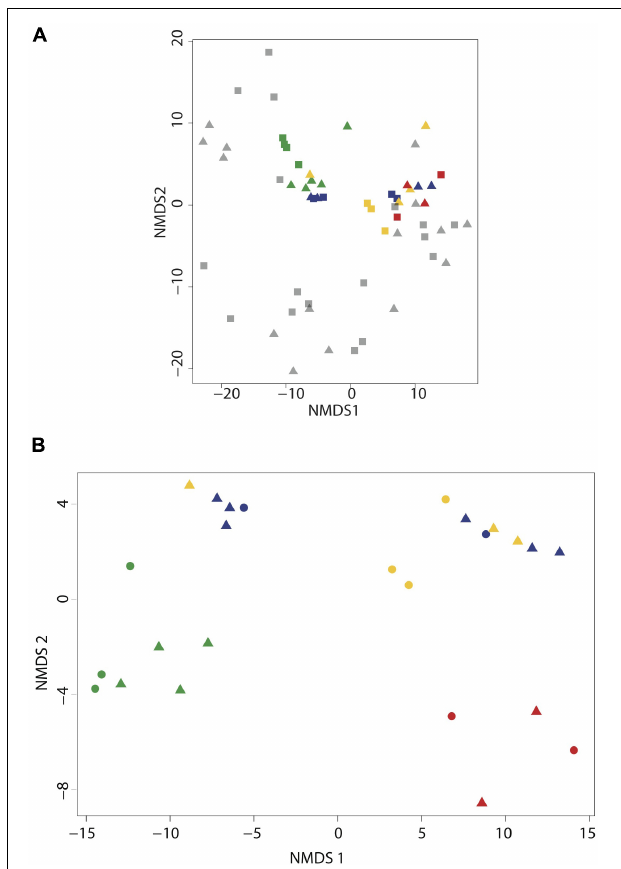
FIGURE 2 | Cluster analysis of small subunit ribosomal RNA (SSU rDNA) gene pyrotag data for the Saanich Inlet time-series (2006–2011) and SCOR workshop samples collected at 165 and 185 m. (A) NMDS based on Manhattan distance (1000 iterations) of time-series and SCOR pyrotag data showing microbial community partitioning based on oxygen gradients spanning suboxic (20–1 µ molO 2 kg - 1 ) and anoxic-sulfidic ( < 1 µ mol O 2 kg 1 ). (B) NMDS based on Manhattan distance (1000 iterations) of SCOR pyrotag data showing microbial community partitioning based on filtering conditions. In both biplots samples are depicted by depth (165 m = square and 185 m = triangle) and filter type [PPS in situ 0.4 µ m (red), MPP on-ship 0.4 µ m (green), 0.22 µ m with in-line 0.4um prefilters (yellow), 0.22 µ m with in-line 2.7 µ m prefilters (blue), and time-series 0.22 µ m (black)].